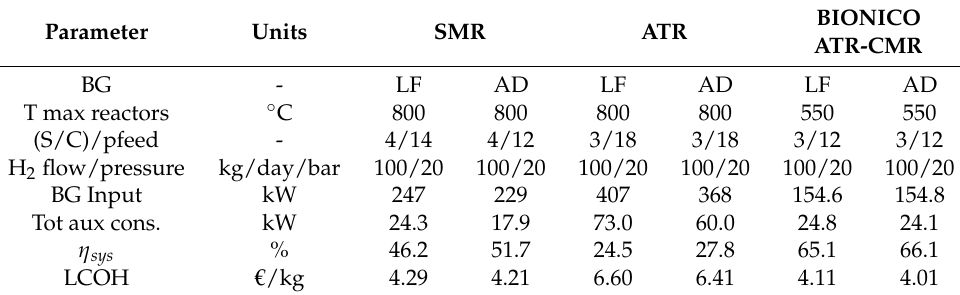
Table 3. Techno-economic results for reference and innovative BIONICO